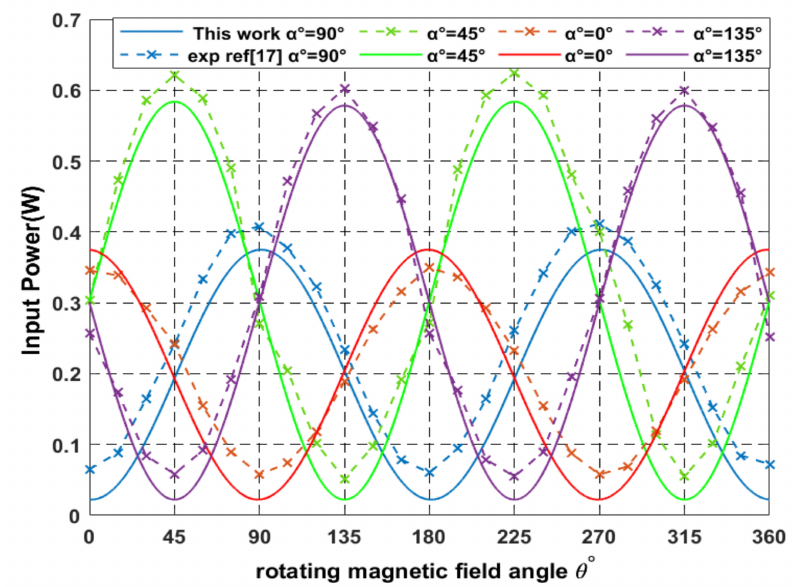
Figure 7. Input power when the receiver is placed at different positions of α ◦ in the presence of a rotating magnetic field.